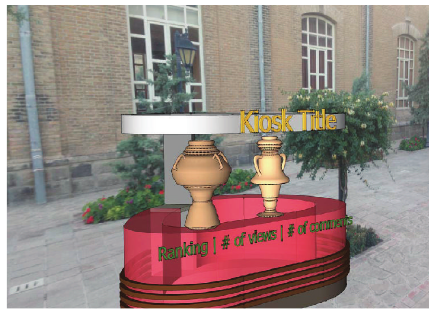
Figure 7: The spot view allows specifying the physical location of a new kiosk. Overlapping boundaries are shown in